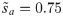
The optimal strategy is robust with respect to noise induced by finite population size in temporally varying environments.(A) Asymptotic mean velocities obtained by numerical integration of the stochastic Fisher Eq (10) for s˜a=0.75, ss = 0.01, s˜b=3 (yellow dot of Fig 2) and different population sizes. (B) The same for s˜a=0.25, ss = 1, s˜b=2 (blue dot of Fig 2). In both panels, the temporal switching rate of the environment is k = 0.001. Green dots corresponds to the results of Fig 3A and 3B for k = 0.001. Insets show a collapse of the curves according to Eq (11), with a fitted value of C = 3.